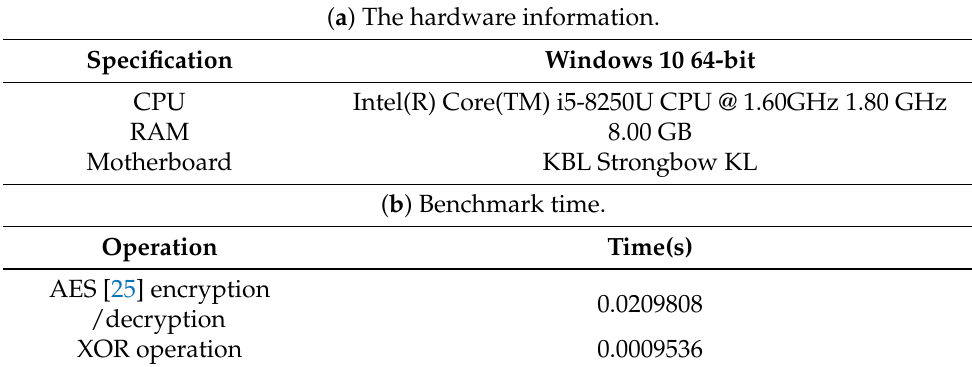
Table 3. Device specification and operation overhead. ( a ) The hardware information.